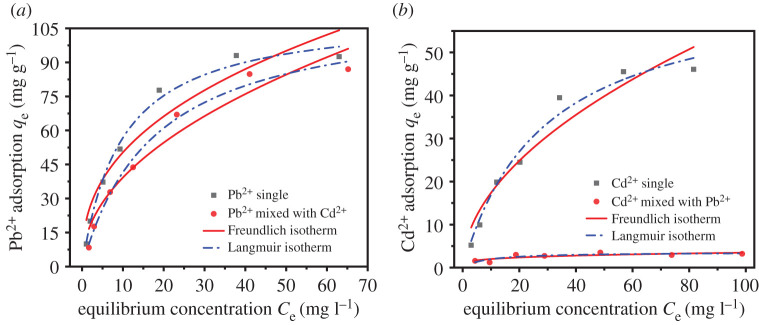
Adsorption isotherm model for Pb2+ (a) and Cd2+ (b) on UVS-NZVI.